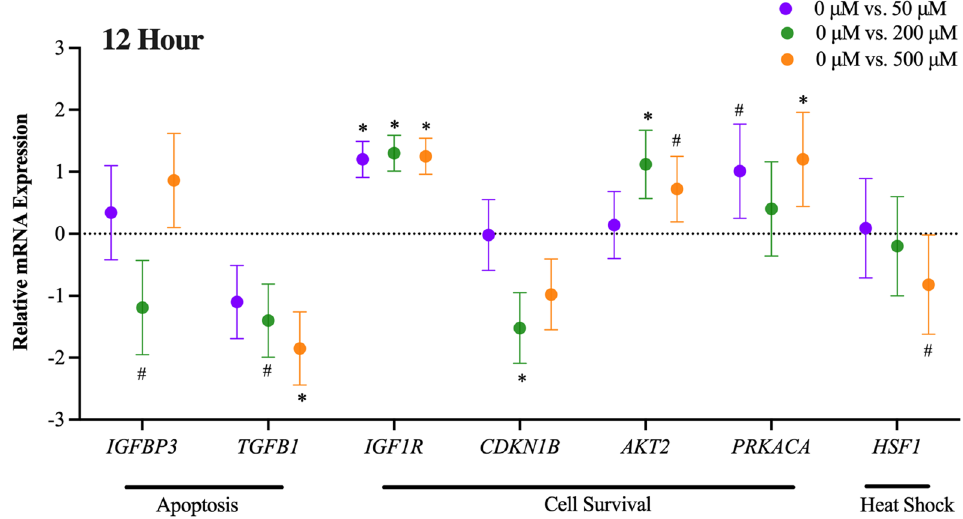
Figure 3. Main effect of 5-Hydroxy-L-tryptophan (5-HTP) dose. Gene expression of primary bovine mammary epithelial cells (pBMEC) cultured with 50, 200 or 500 μM of 5-HTP for 12-h. Data is presented as relative mRNA expression (∆∆Ct = ∆Ct Dose 0 (CON) − ∆Ct Dose 50, 200 or 500)) ± standard error of the mean (SEM). Positive and negative ∆∆Ct indicates upregulation and downregulation, respectively. Significance declared at P value ≤ 0.05 (*) and (#) denotes a statistical tendency at 0.05 < P value ≤